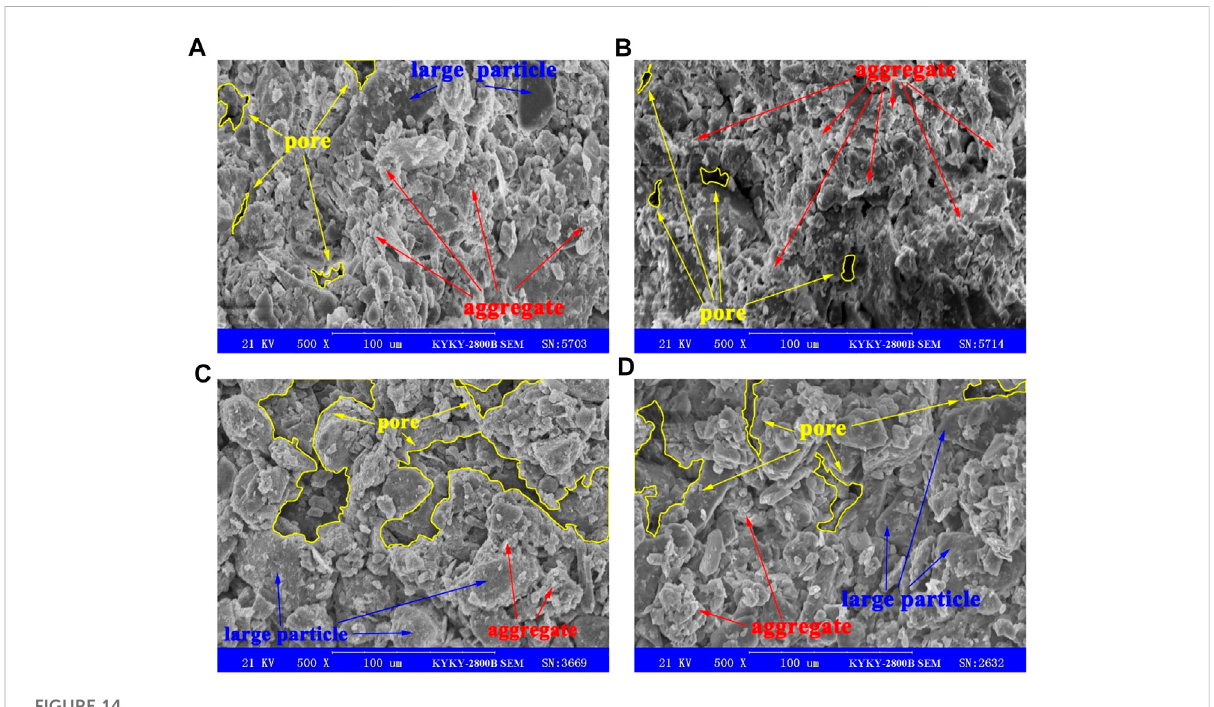
FIGURE 14 SEM image of the typical loess in the study area and the Loess Plateau. The study area: (A) Huangyagnchuan, Gulang; (B) Xiashancun, Gulang. Loess Plateau: (C) Guyuan; (D) Xiji.